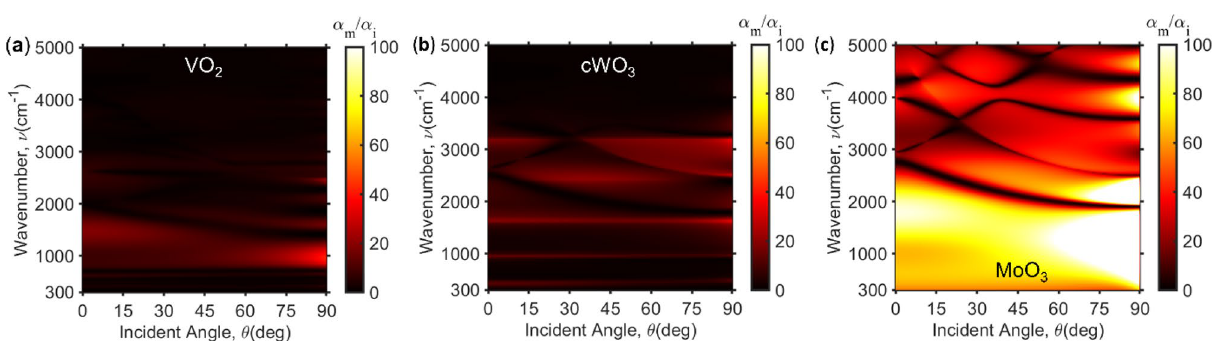
Figure 5. Absorptance ratio (α m /α i ) contour in respect with incident angle and wavenumber for ( a ) VO 2 , ( b ) cWO 3 , and ( c ) MoO 3